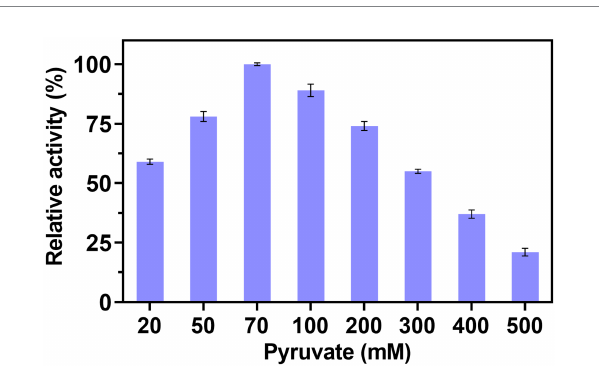
FIGURE 3 Effect of pyruvate concentration on the multi-enzyme